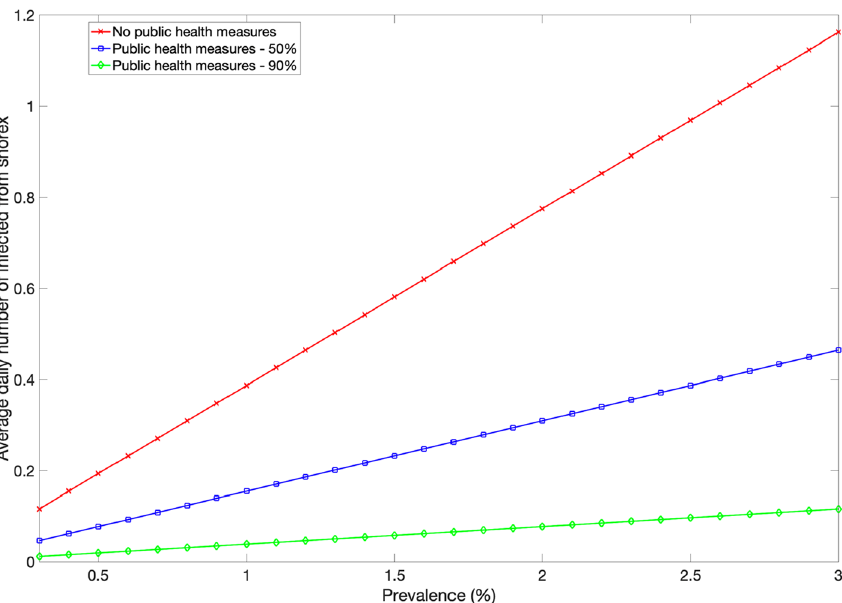
Figure 4. Illustration of the average daily number of infected individuals from shore excursions (shorex) as a function of the local prevalence and the extent of public health measures (e.g., facemask wearing). The number of infected passengers arising from daily shore expeditions depends on the number of susceptible passengers, the local reproduction number R0(shore), the local COVID-19 prevalence level, the amount of time that passengers spend on shore excursions (about 6 h) as well as the extent of public health measures in place (e.g., facemask wearing). Here R0(shore) = 1.0. The extent of public health are modeled as a proportionate reduction in the transmission probability per contact which is assumed to vary from 50 to 90%. This is likely a conservative range that reflects the combined impact of enhanced surface sanitation, mandatory facemask wearing on board for passengers and crew, physical distancing protocols, air purifiers, and UV lights in all air handling